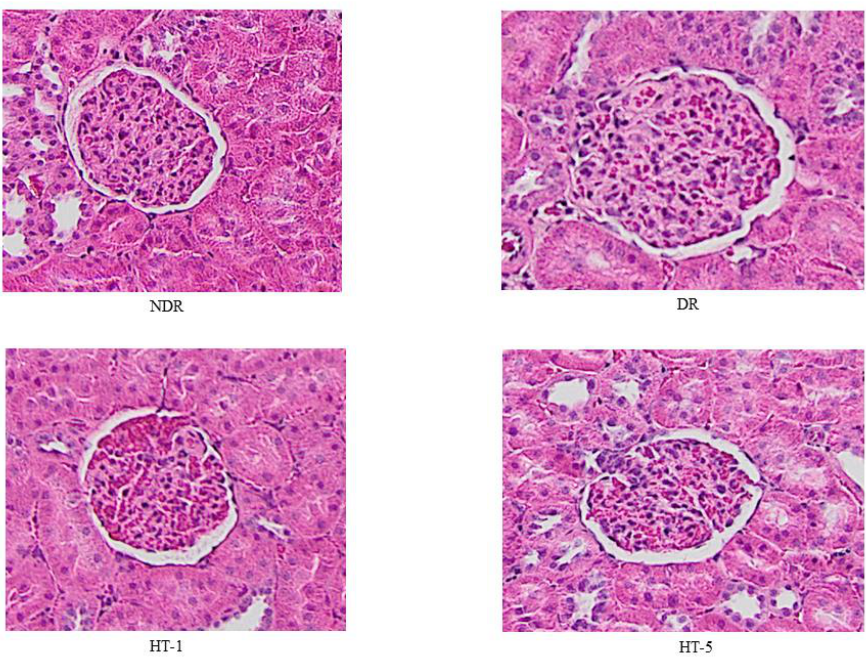
Figure 3. Representative examples of glomerular images from control nondiabetic rats (NDR), control diabetic rats (DR), and DR treated with hydroxytyrosol 1 mg/kg/day p.o. (HT-1) or 5 mg/kg/day p.o. (HT-5). Hematoxylin–eosin ( × 10).